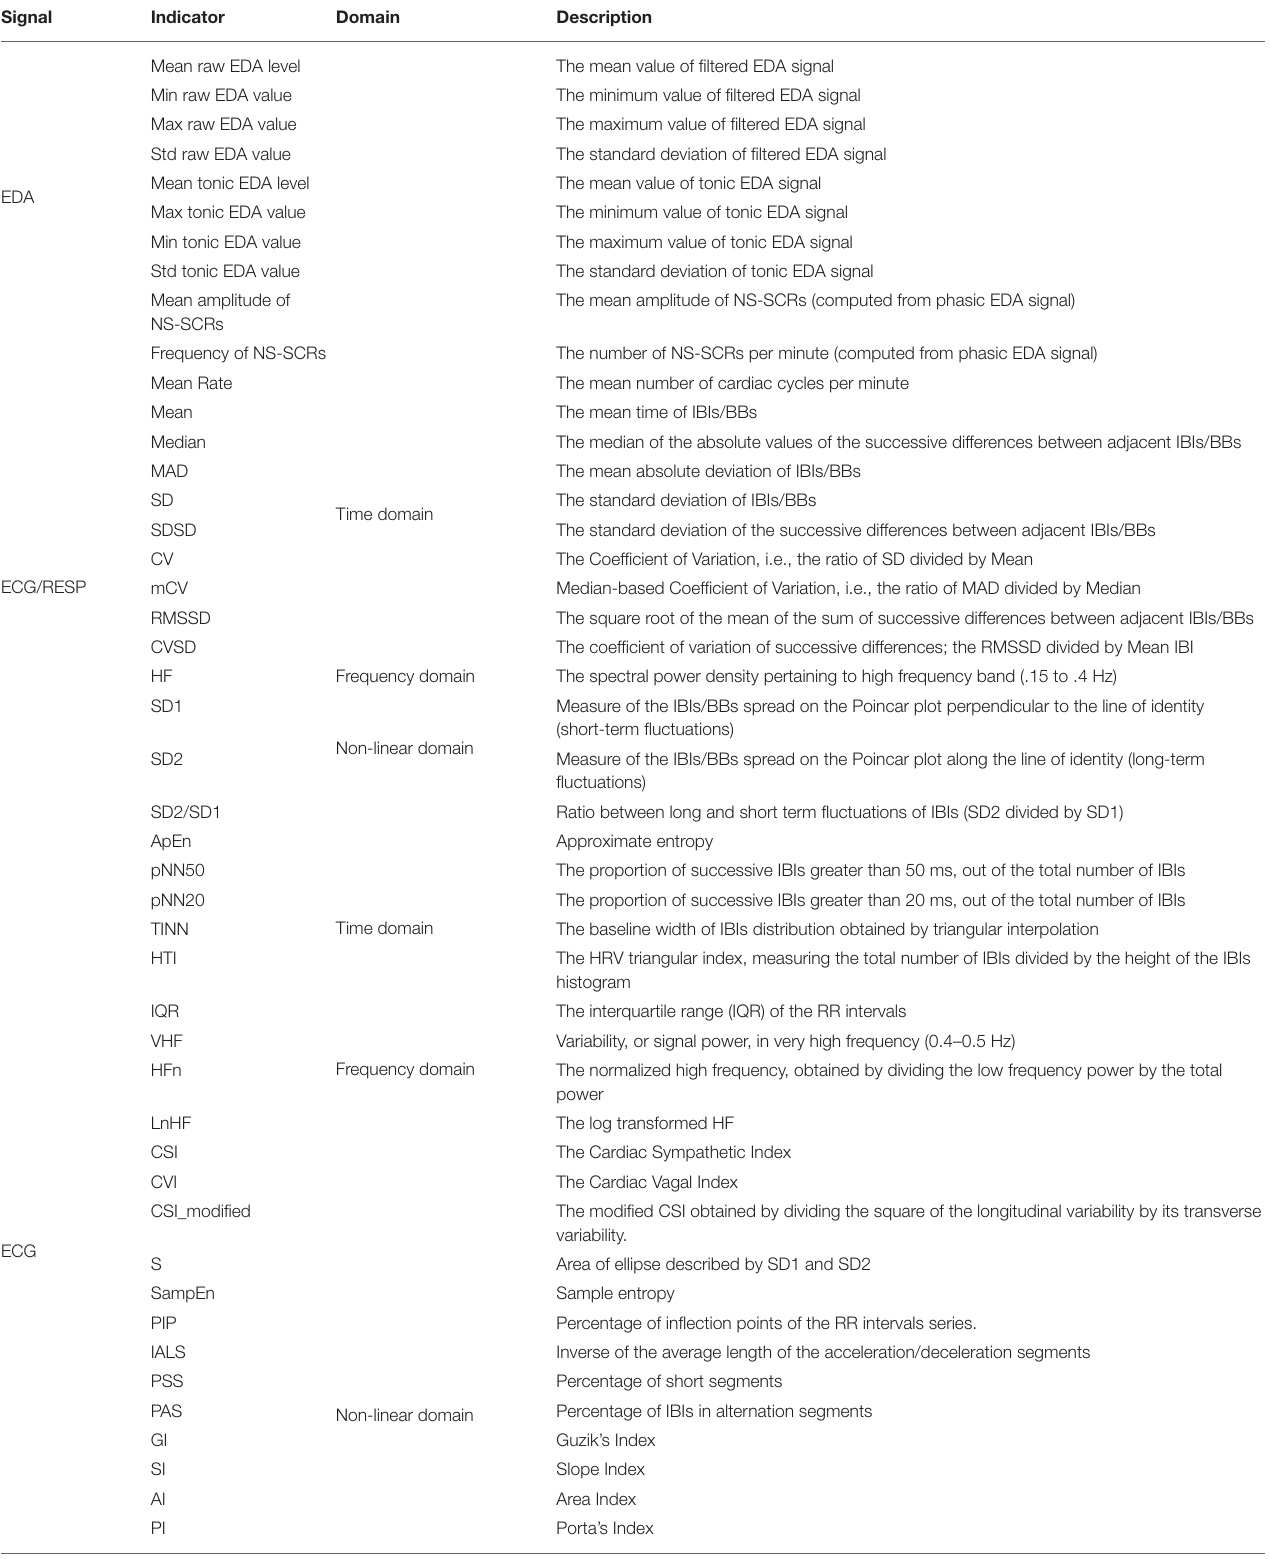
TABLE 2 | Indicators calculated from raw physiological signals collected from participants.